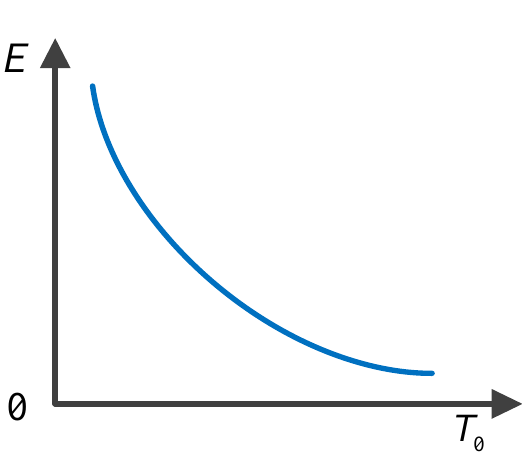
Figure 11. Energy consumption and journey time.